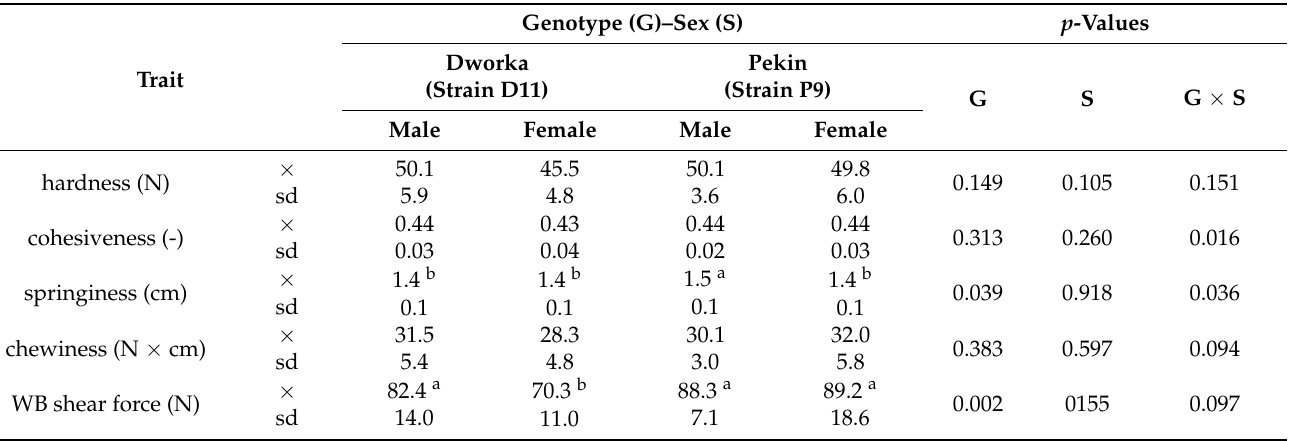
Table 6. Mean values ( × ) and standard deviation (sd) of the texture parameters of the greater pectoral muscle of 113-week-old ducks.